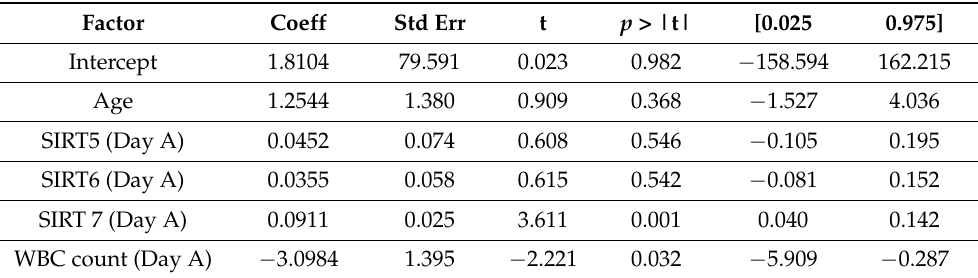
Table 4. Results of OLS regression performed to examine how CD34+ peak value on the day of first apheresis is influenced by age, SIRT5, SIRT6, and SIRT7 expression, and white blood cell (WBC) count on day